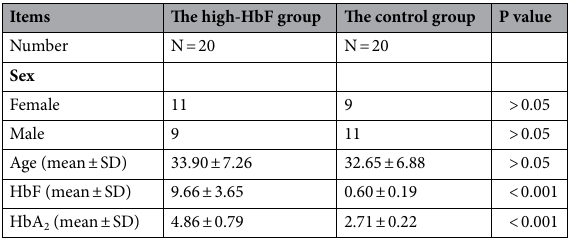
Table 1. Characteristics of the